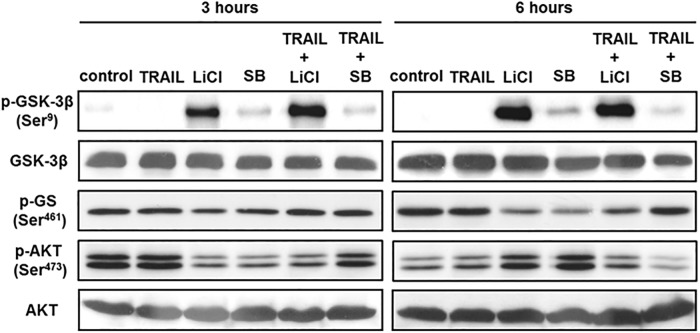
Phosphorylation of GSK-3 and AKT are not modified by GSK-3 inhibitor during its sensitization of TRAIL-induced apoptosis.AGS cells were treated with or without TRAIL (25 ng/mL), LiCl (20 mM) or SB (25 μM) for 3 hours and 6 hours. GS, AKT and GSK-3β phosphorylation expression were analyzed by Western blotting of AGS whole extracts. AKT was detected by total AKT monoclonal antibody, which detects endogenous levels of AKT and does not cross-react with related proteins. We used pan Akt phospho Ser473 to enable the homogeneous detection of all phospho Akt isoforms for oncology. Blots are representative of four independent experiments.